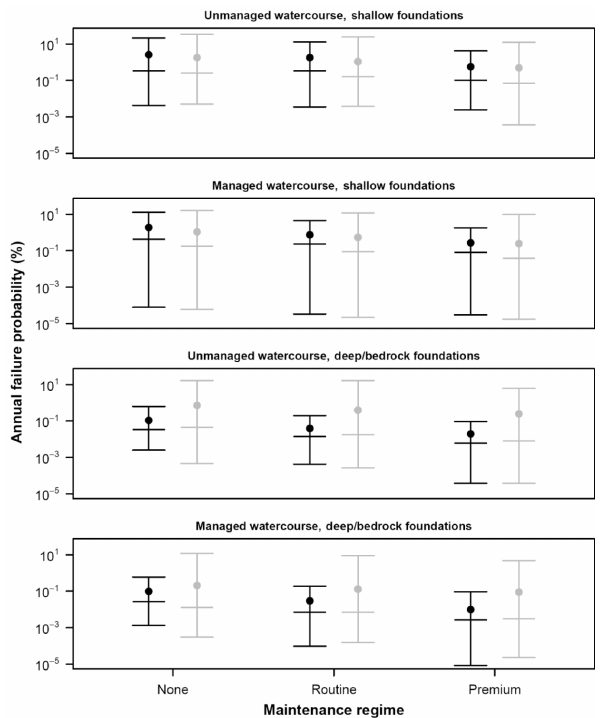
Figure 4. Fragility estimates for annual unconditional bridge fail- ure probability under three assumed monitoring and maintenance regimes.